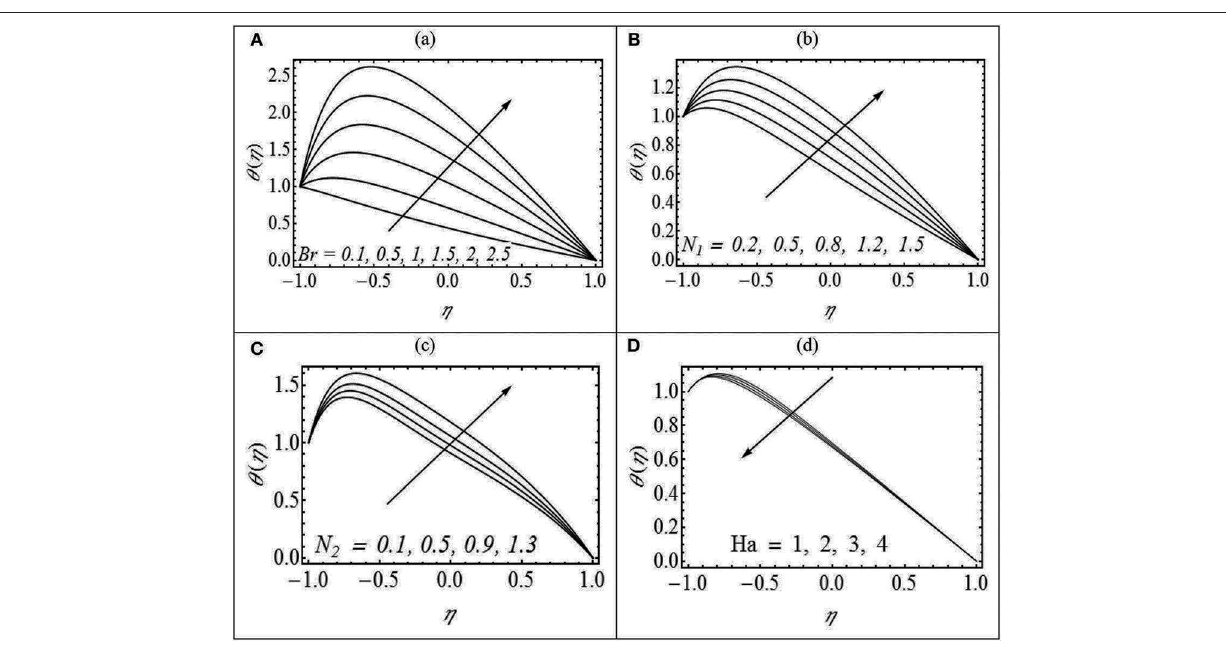
Frontiers in Physics |